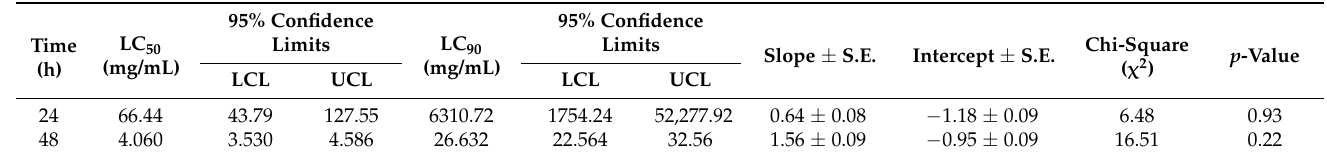
Table 2. Medium lethal concentration causing 50% and 90% mortalities (LC 50 and LC 90 values) of D. innoxia plant leaf extract against R. microplus in vitro.